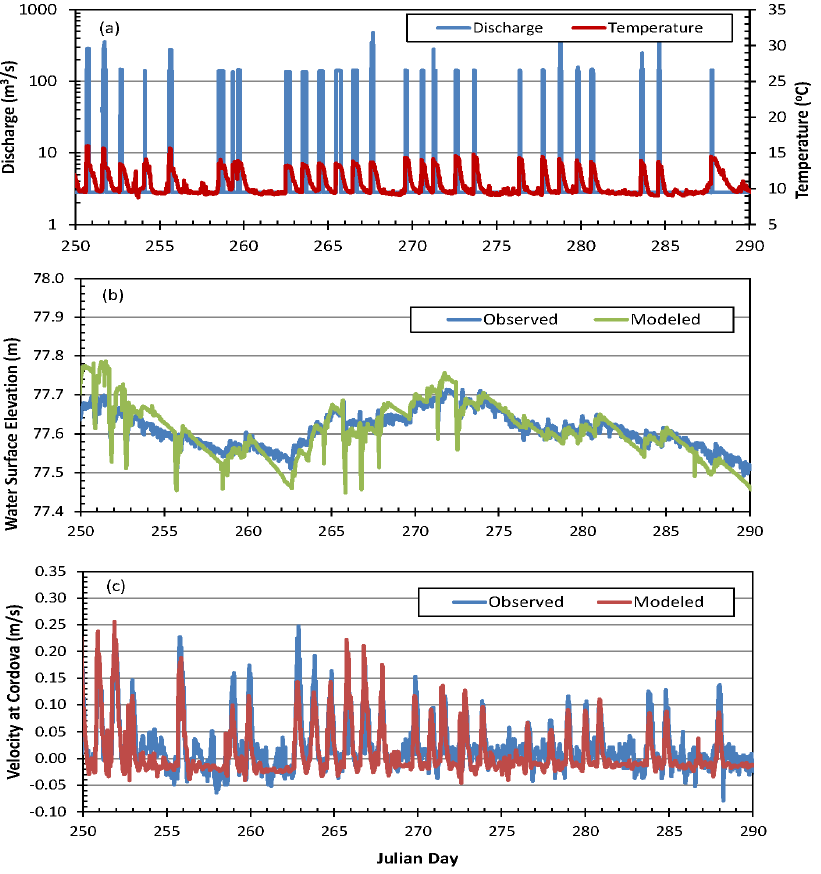
Figure 2. ( a ) Time-series plot of discharge and water temperature at the Smith Dam tailrace; ( b ) time-series plot of observed and modeled water surface elevation (m) at GOUS; and ( c ) time-series plot of modeled (depth averaged) and observed velocity at the USGS Cordova gauging station from 8 September to 18 October (Julian day 250 to 290)